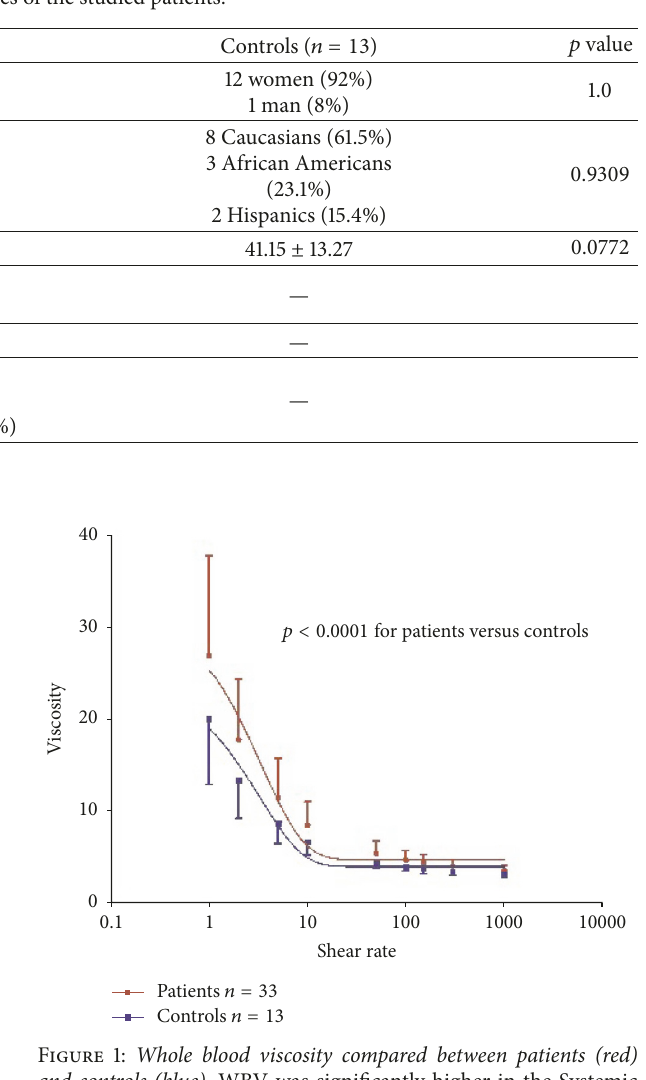
Table 1: Characteristics of the studied patients.